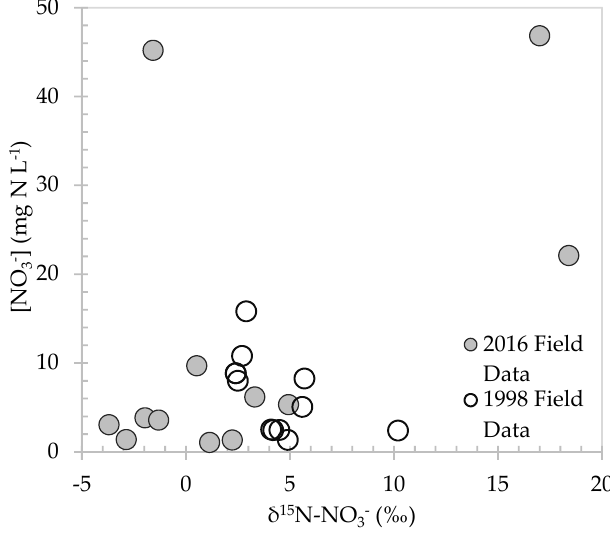
Figure 8. Comparison of [NO 3 − ] and δ 15 N ‐ NO 3 − for 1998 and 2016 field data. Far right data points are from Well 1G ‐ S and suggest organic nitrogen source.